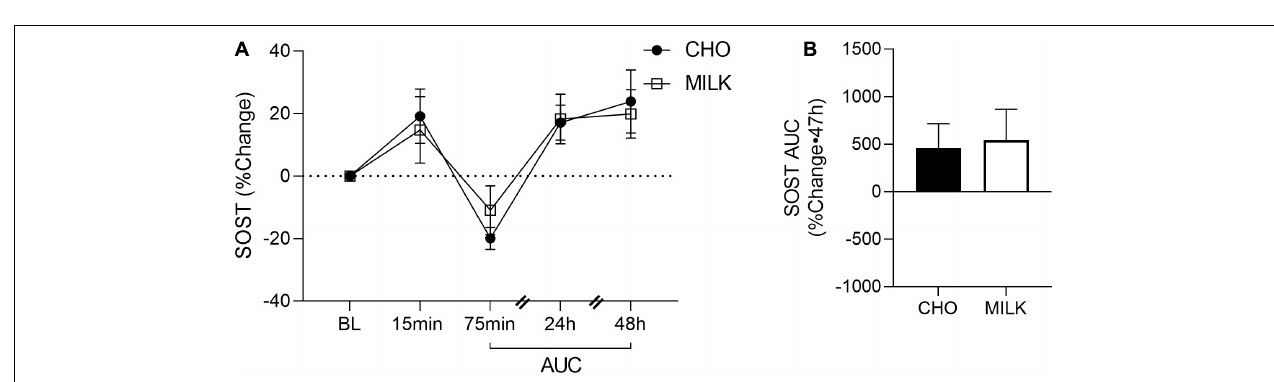
FIGURE 3 | Percent change post-exercise (A) and area under the curve from 75-min to 48-h (B) for osteocalcin (OC) in the CHO and MILK trials. Values are means ± SEM. N = 12. BL, baseline; AUC, area under the curve.